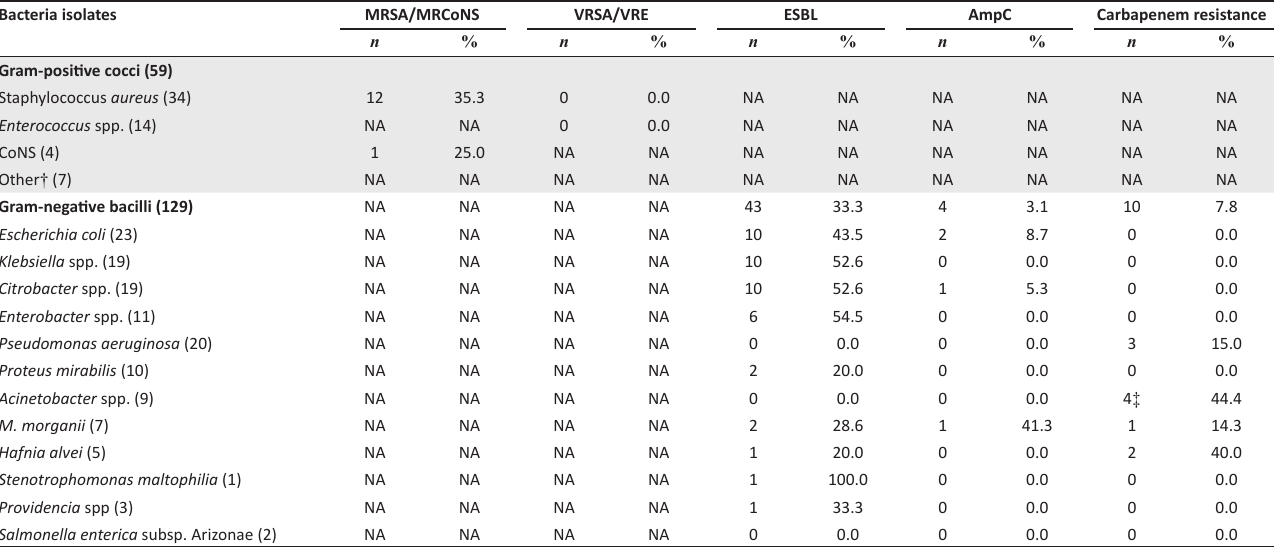
TABLE 5: Types and mechanisms of antibiotic resistance among bacterial agents of infected diabetic foot ulcer from tertiary healthcare facilities in Osun state, Nigeria, July 2016 to April 2017. Bacteria